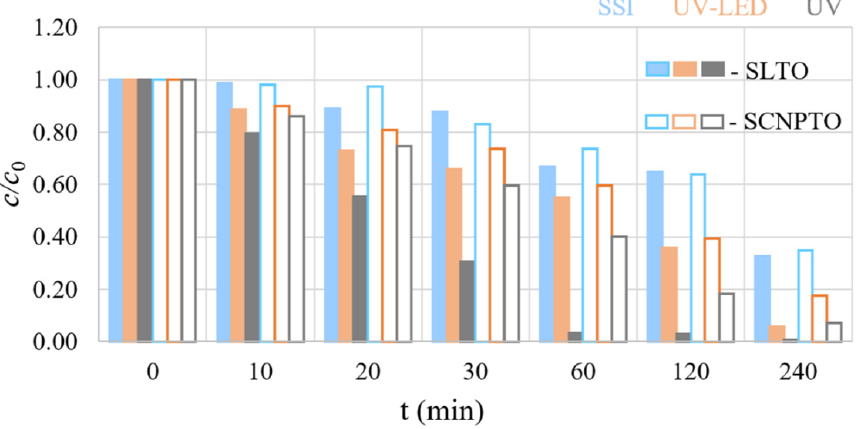
Figure 4. Kinetics of pindolol photocatalytic degradation under different types of irradiation in the presence of